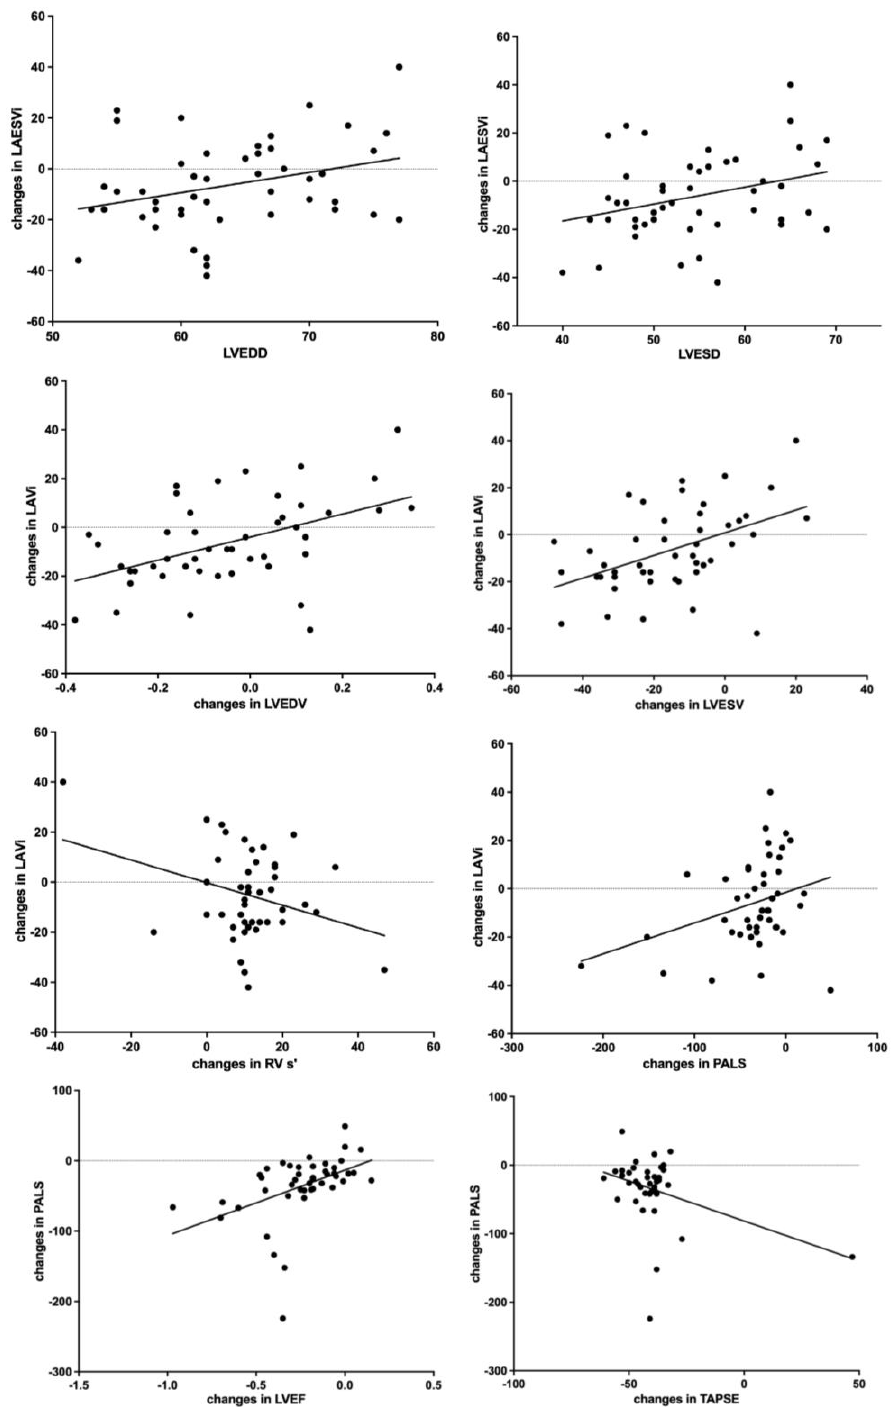
Figure 1. Correlations between changes in LEASVI and LVEDD, LVESD, changes in LVEDV, changes in RV S’ and changes in PALS, and between changes in PALS and changes in LVEF and TAPSE. (Changes are expressed as %, LVEDD and LVESD in mm). I del.